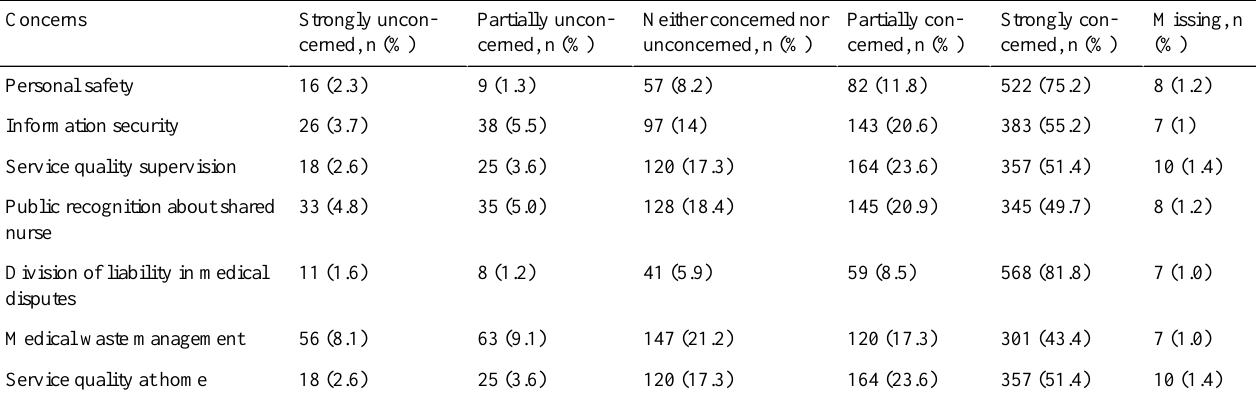
Table 1. Concerns about home visiting as a shared nurse